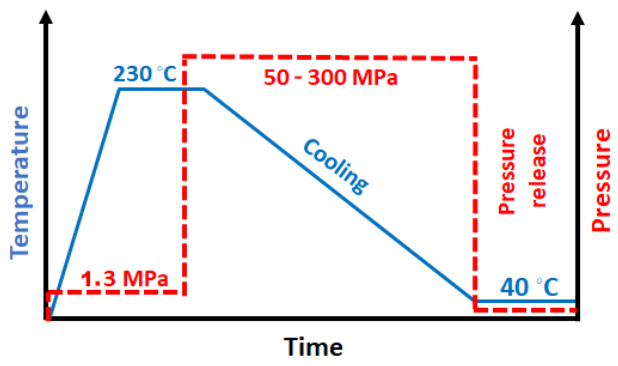
Figure 1. Pressure and temperature protocol.